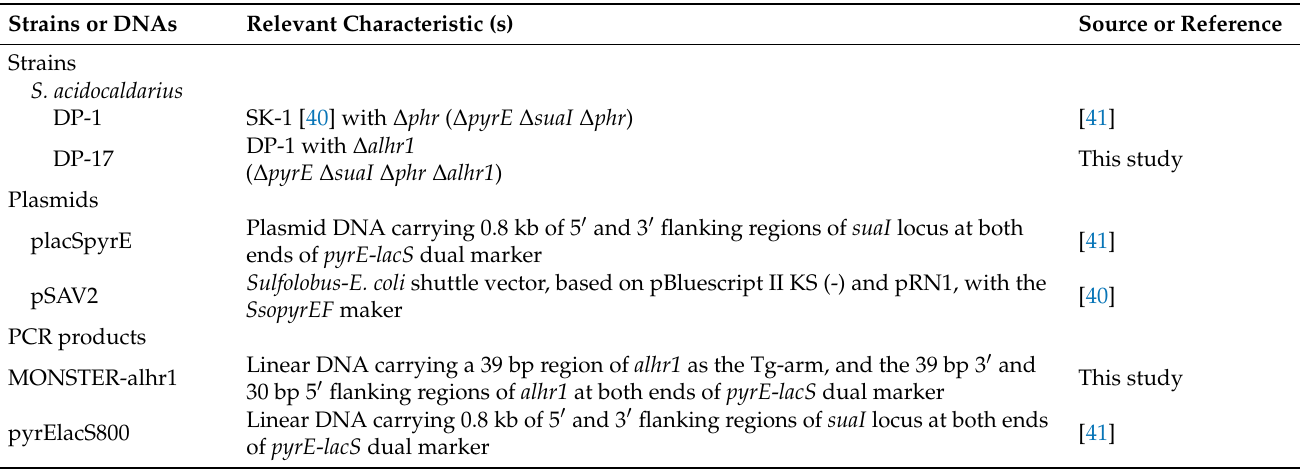
Table 1. Strains or DNAs used in genetic